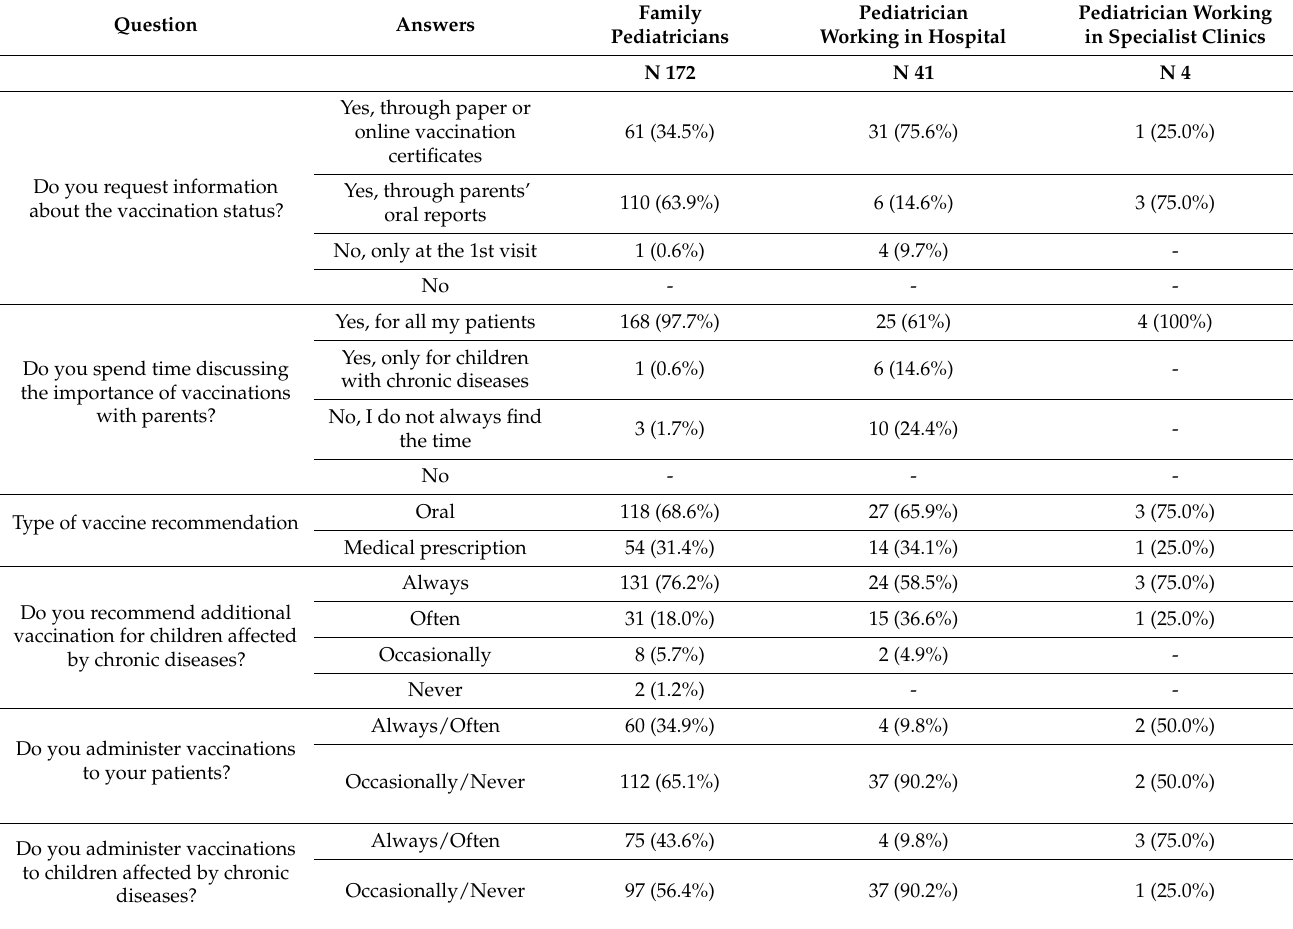
Table 2. Vaccination practices, according the working place of